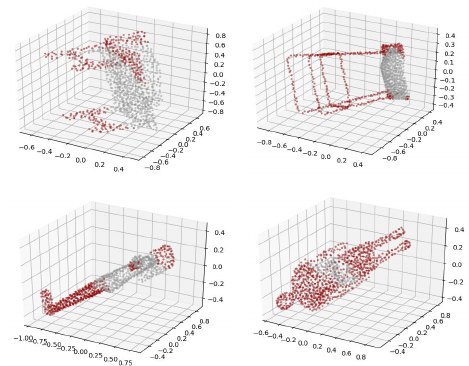
Figure 5. The CAMs of two classes from ModelNet40. The maps highlight the discriminative input point cloud regions used for point cloud classification, the chair legs for chairs and the head and leg in humans.